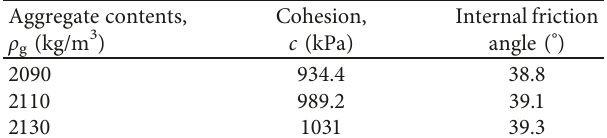
Table 5: Cohesion and internal friction angle under different